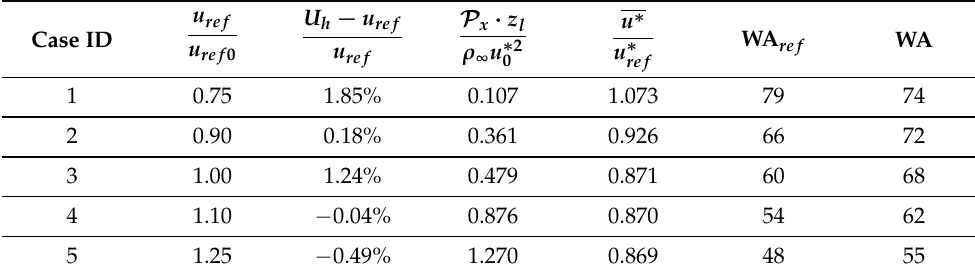
Figure 8. Time histories of non-dimensional: ( a ) wind speed at S z + , with target values denoted in the horizontal lines; ( b ) friction velocity; ( c ) large-scale pressure gradient; and ( d ) form drag. Averaged with t avg = 75 T 0 . Wavy bottom application. Table 1. The parameters of Figure 8 probed in the final time-step, and the corresponding reference values.